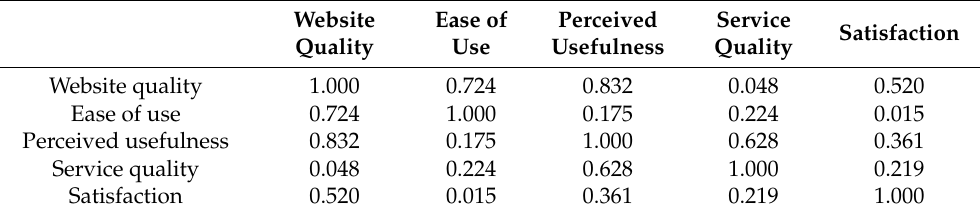
Table 7. Correlations.